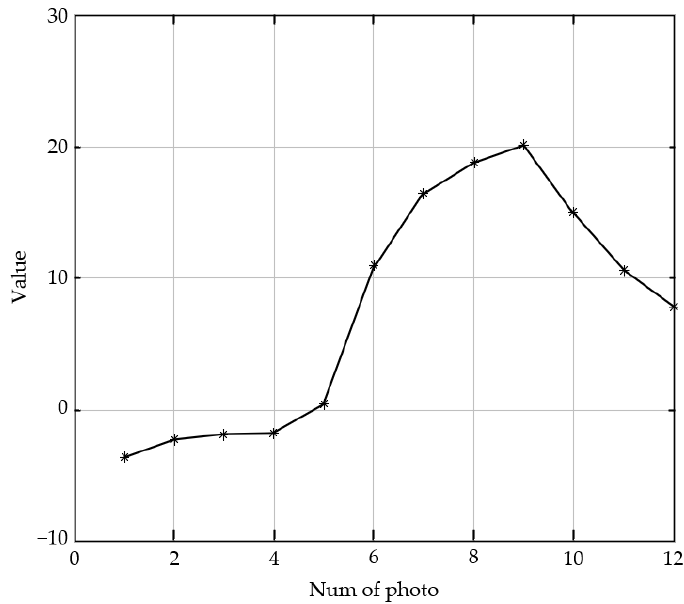
Figure 3. Predictive scores of the defocused image sequence.